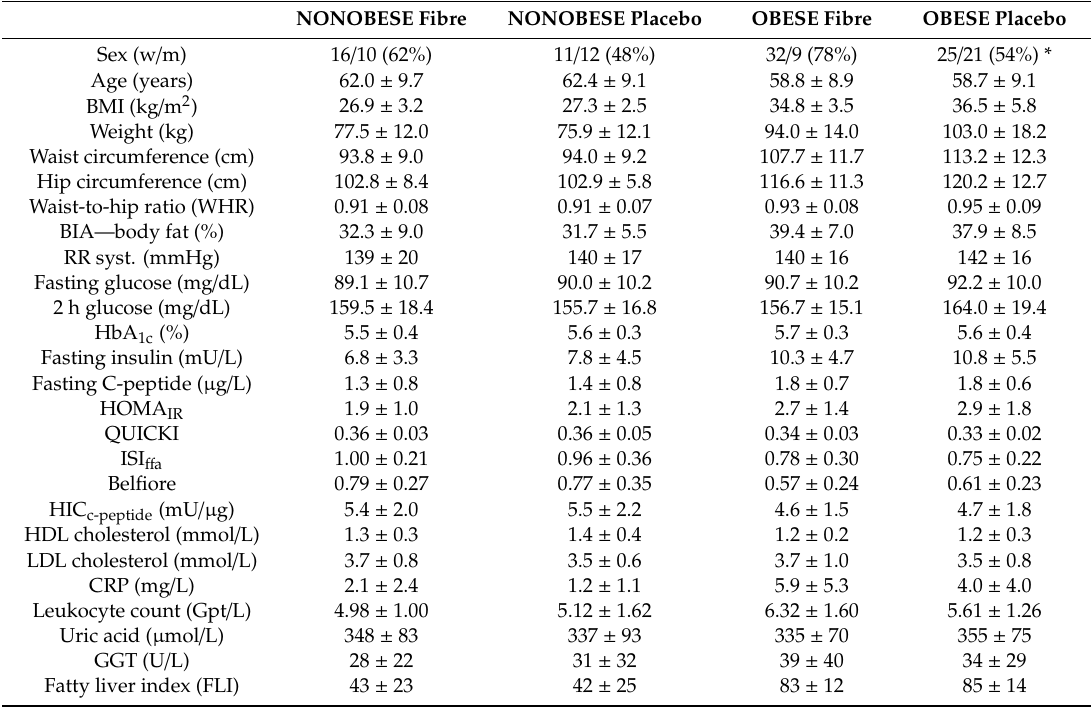
Table 1. Characteristics of participants at study